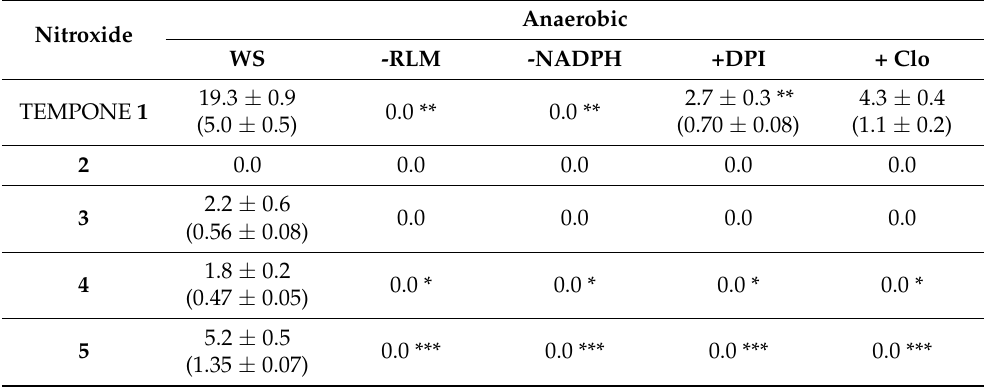
Table 2. Initial rates of decrease (nmol · min − 1 · mg − 1 · prot) ((nmol · min − 1 · nmol − 1 · P450)) of exam- ined nitroxides (100 µ M) in the presence of rat liver microsomes (RLM), and various cofactors and inhibitors (Clo: clotrimazole; DPI: diphenyliodonium chloride) upon anaerobic conditions (*** = p < 0.001, ** p < 0.01 and * = p < 0.05 for difference from whole system (WS)). The samples were prepared in potassium phosphate buffer (100 mM, pH 7.4, containing 1 mM DTPA). WS